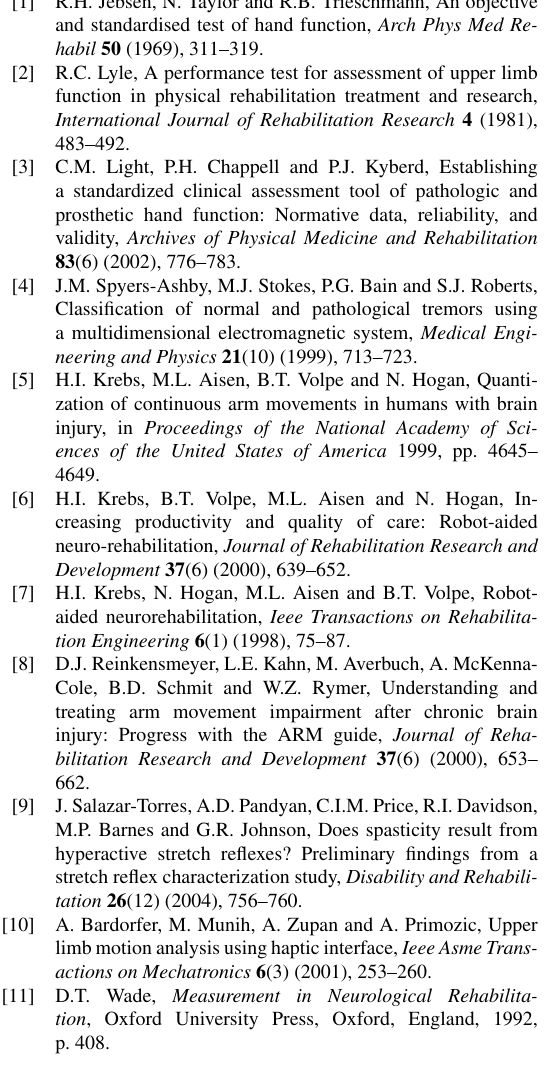
F. Amirabdollahian and G. Johnson / Analysis of the results from use of haptic peg-in-hole